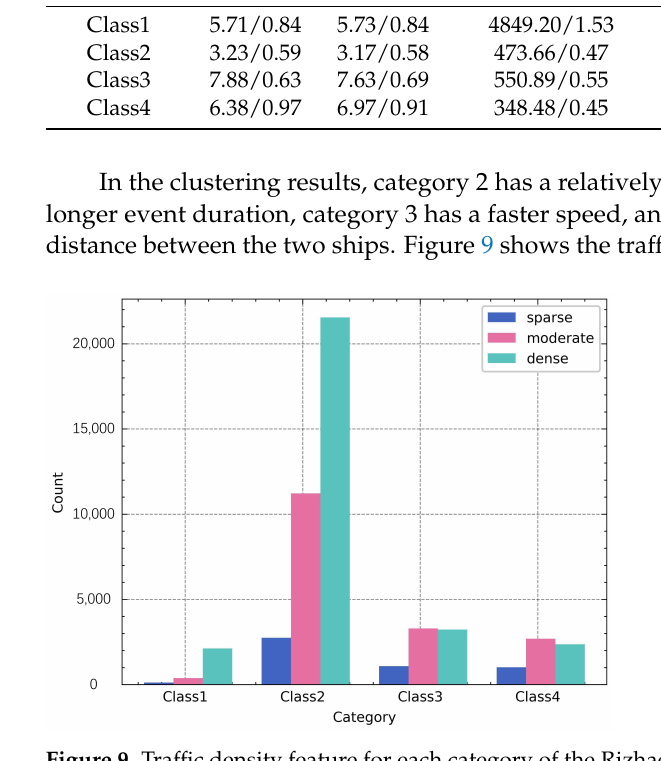
Figure 9. Traffic density feature for each category of the Rizhao, China dataset.